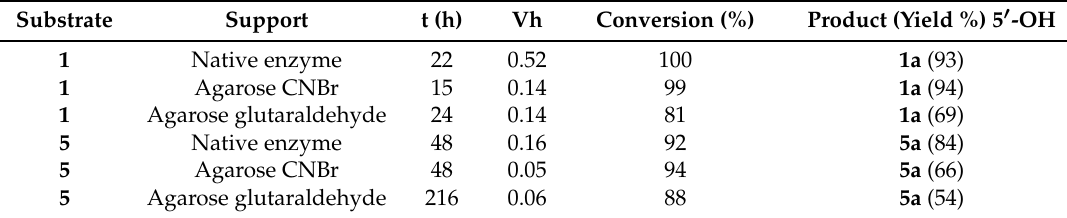
Table 3. Enzymatic screening of peracetylated nucleosides ( 1 , 5 ) by immobilized protease N. Substrate